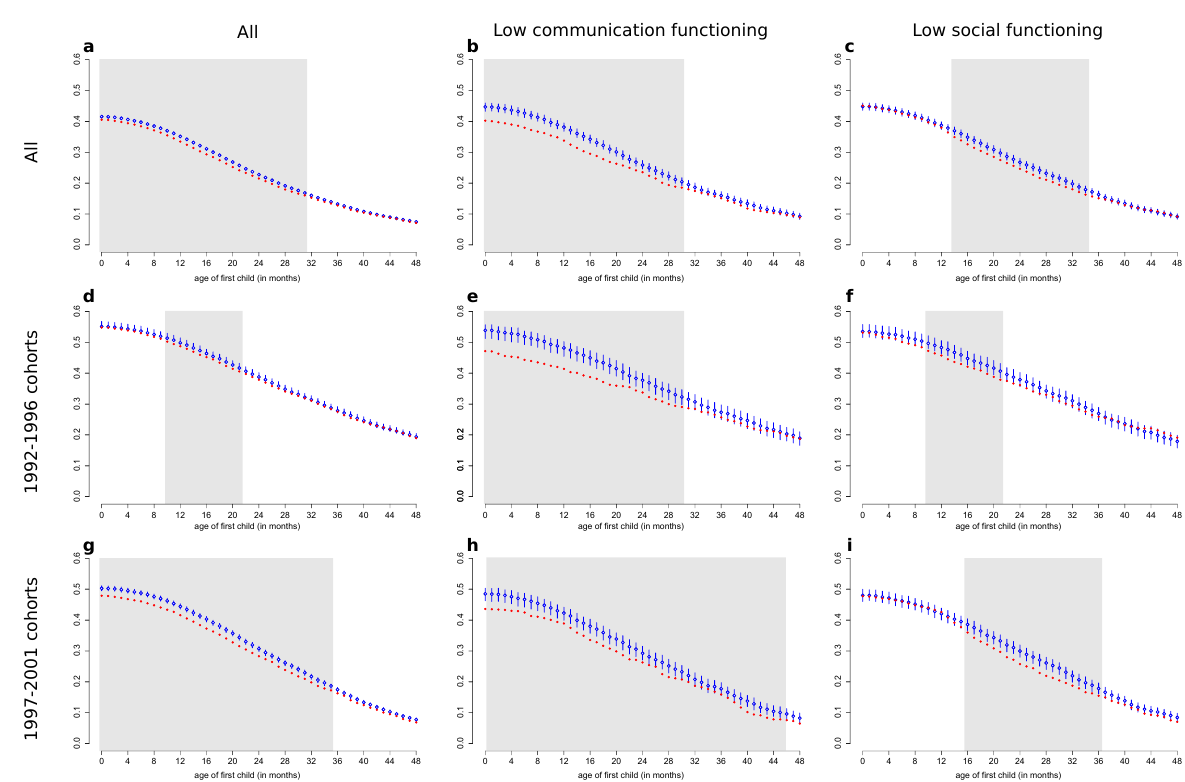
Figure 1: Proportion of mothers of firstborn children with (solid red circles) and without (open blue circles) autism who conceived a subsequent child at each given age of the first child, relative to those who have yet to conceive a second child, stratified by severity group and birth cohort. Shaded areas indicate significant effects of the first child’s autism status on subsequent